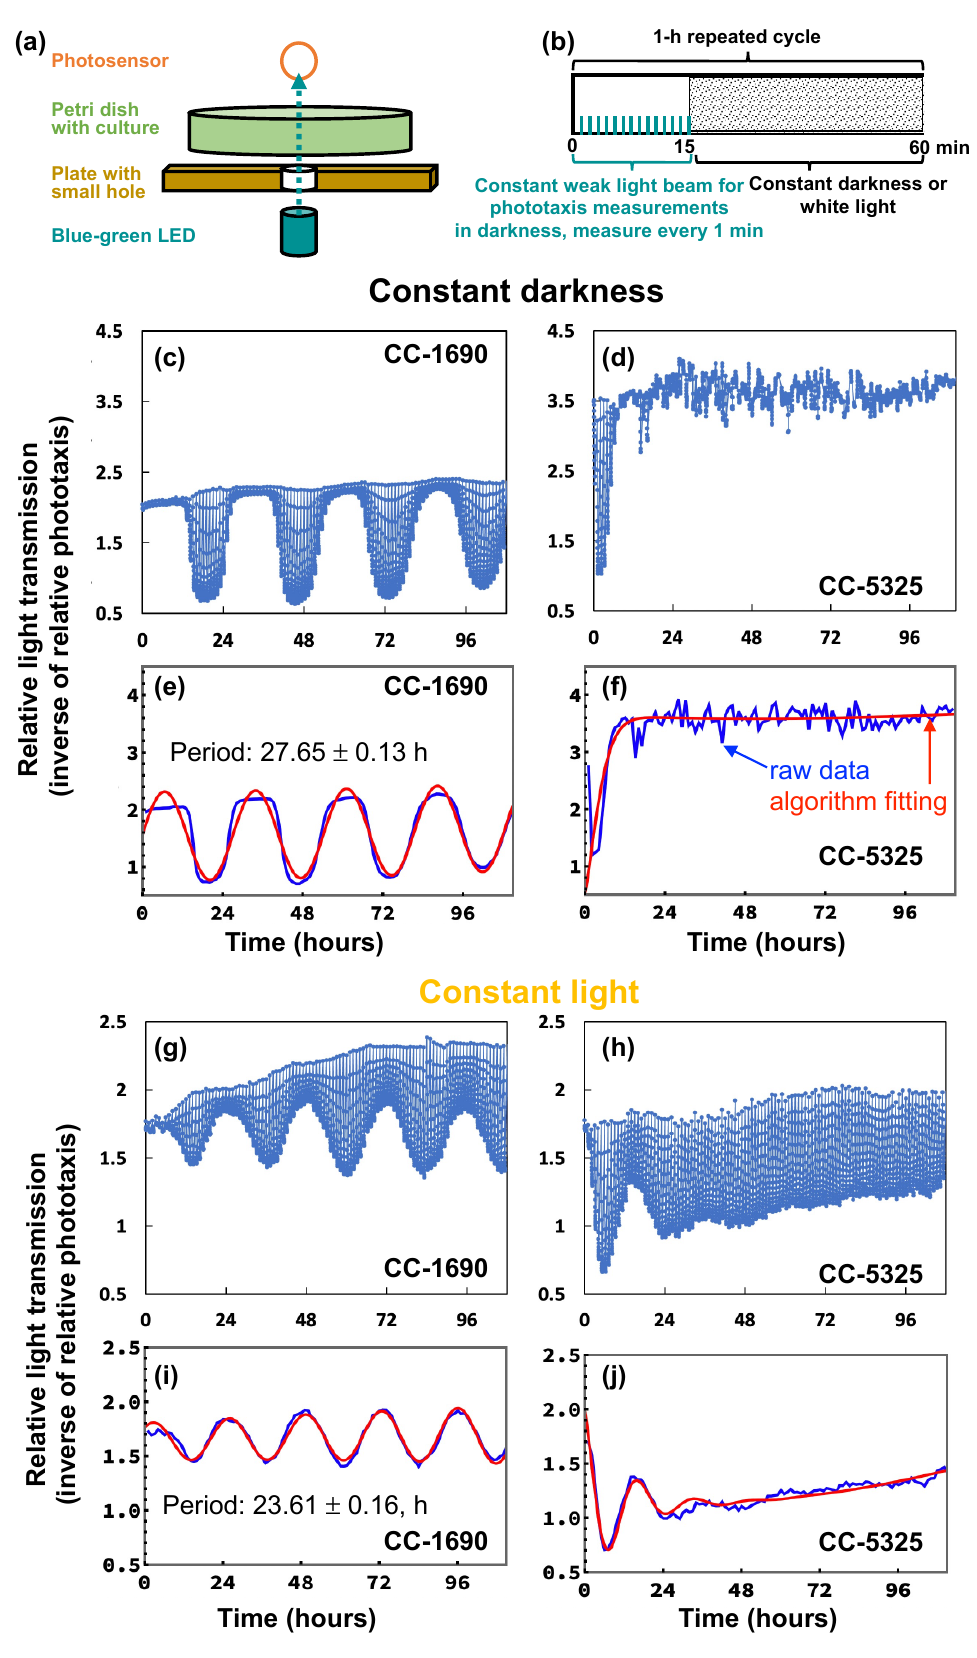
Figure 9. In constant darkness or constant light, CC-1690 maintained a sustained circadian rhythm of phototaxis but CC-5325 could not. ( a , b ) Schematic drawing of how the phototaxis machine collected data. Repeated every hour (h), the consecutive blue-green light-emitting diode (LED)